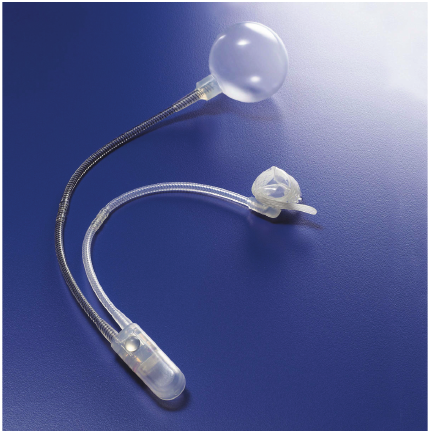
Figure 1: AS 800 (Used by permission of American Medical Systems, Minnetonka, MN,